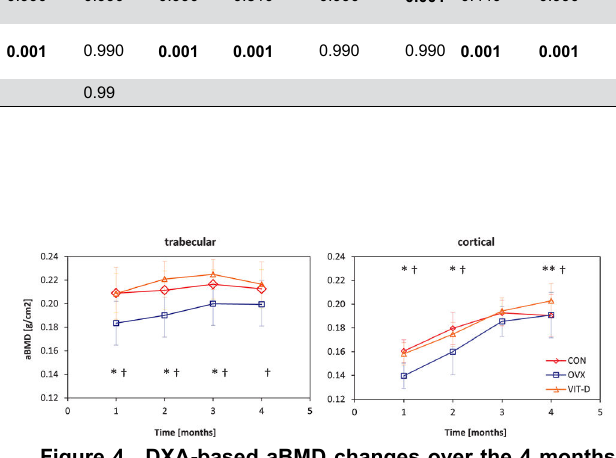
uCT-based Measurements